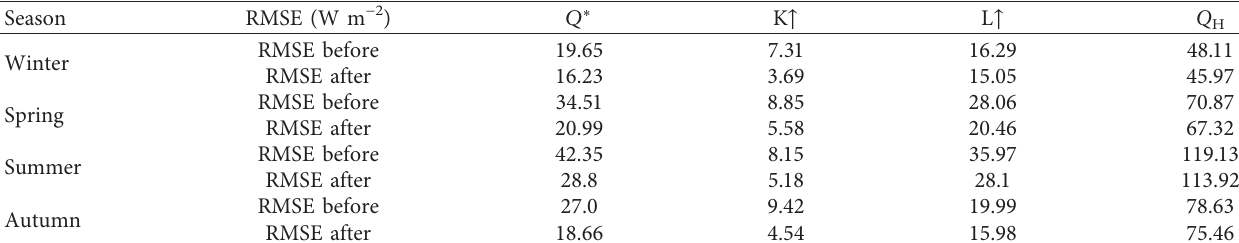
Table 3: Comparison of RMSE for each flux before and after parameter